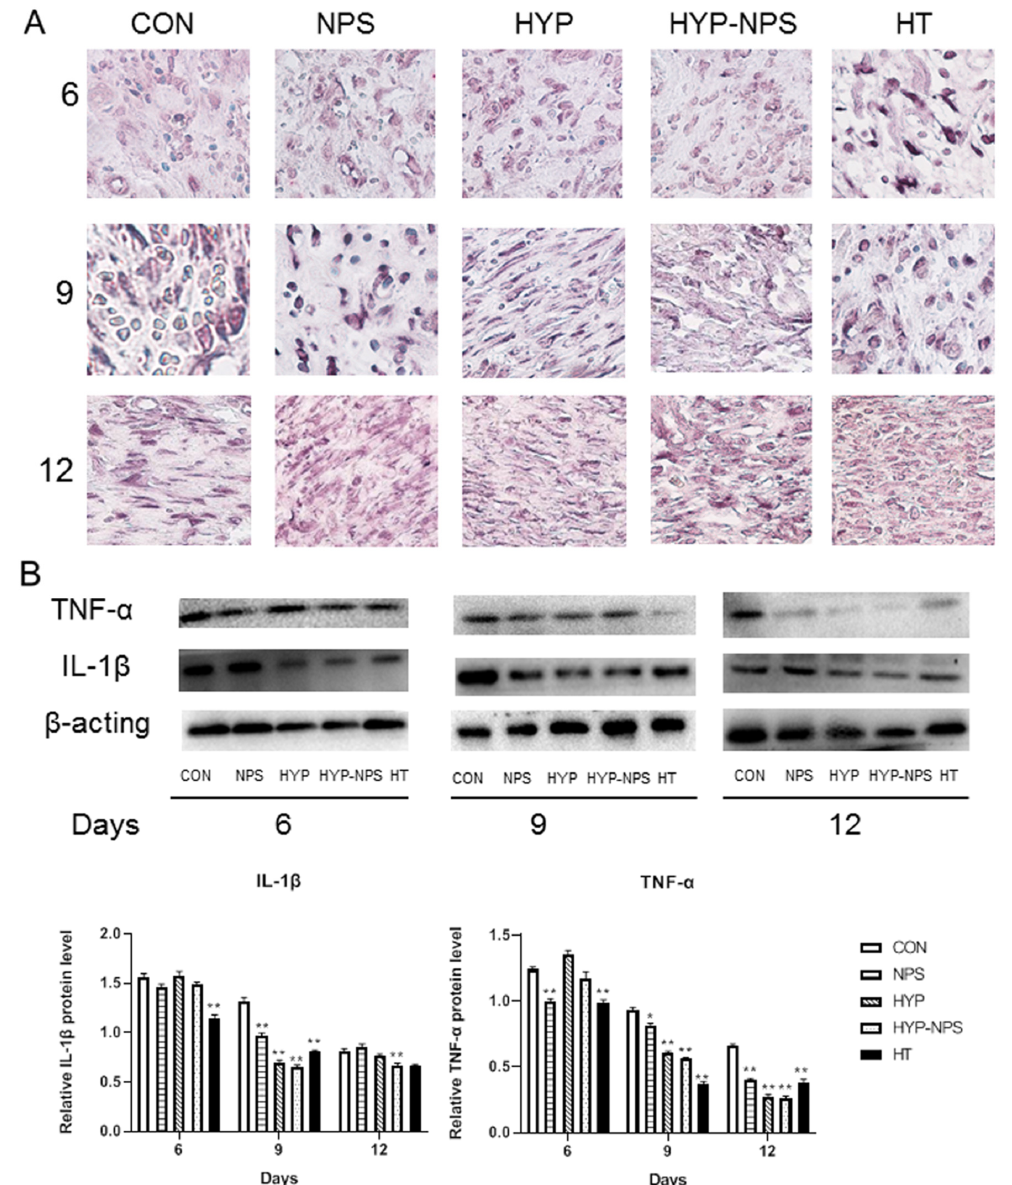
Figure 7. HYP-NPS can down-regulate IL-1 β and TNF- α expression levels. ( A ) IHC staining of skin sections on the 6th, 9th, and 12ths day post-wounding (magnification 400×). ( B ) Western blotting showing protein expression levels of TNF- α and IL-1 β . Values are mean ± SD. * p < 0.05 and ** p < 0.01 compared to the CON group. The arrows represent IL-1 β expression.